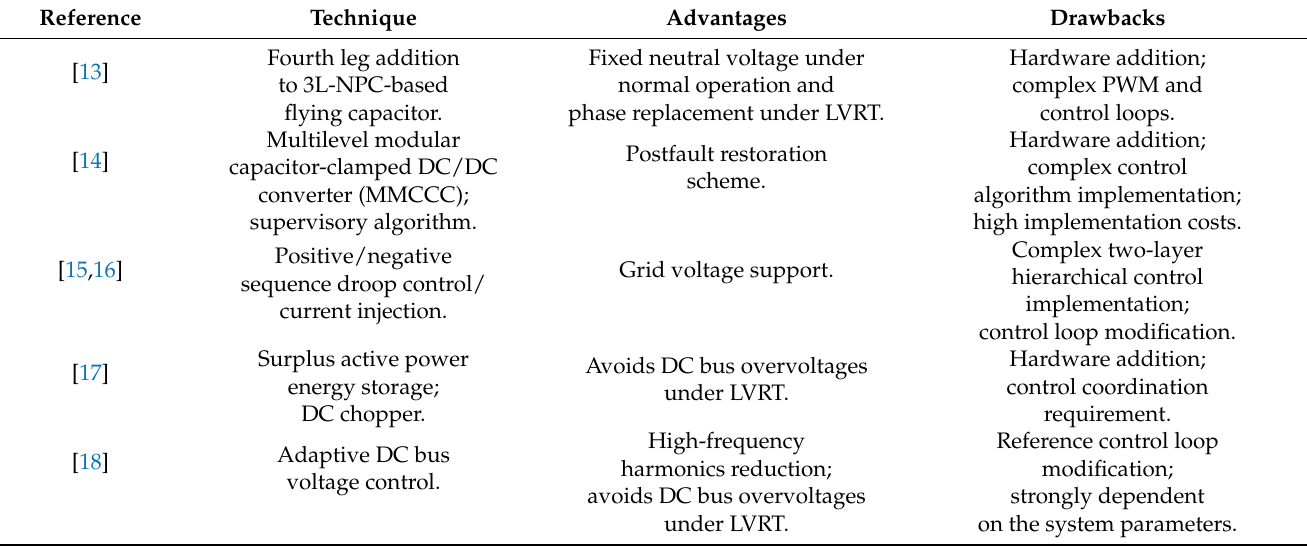
Table 1. Summary of hardware- and control-based LVRT